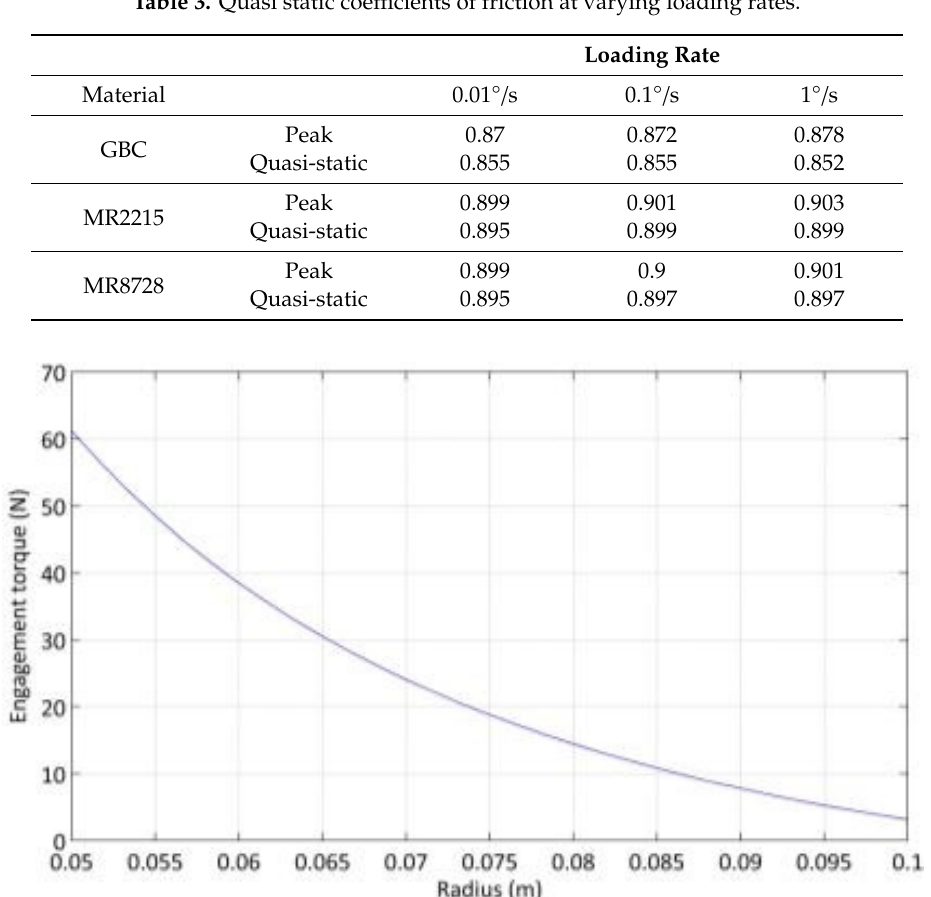
Table 3. Quasi static coe ffi cients of friction at varying loading rates.